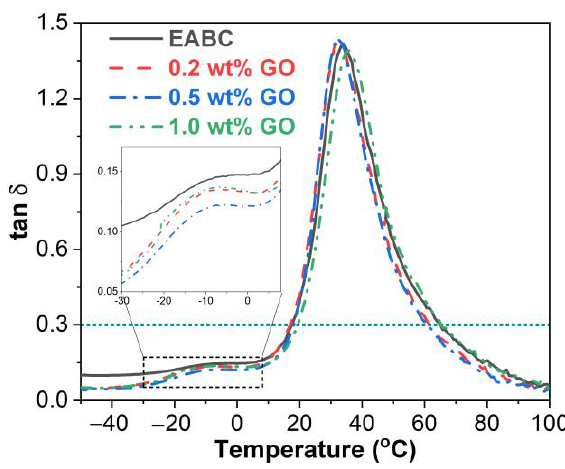
Figure 9. Loss factor versus temperature curves of the unmodified and GO-modified